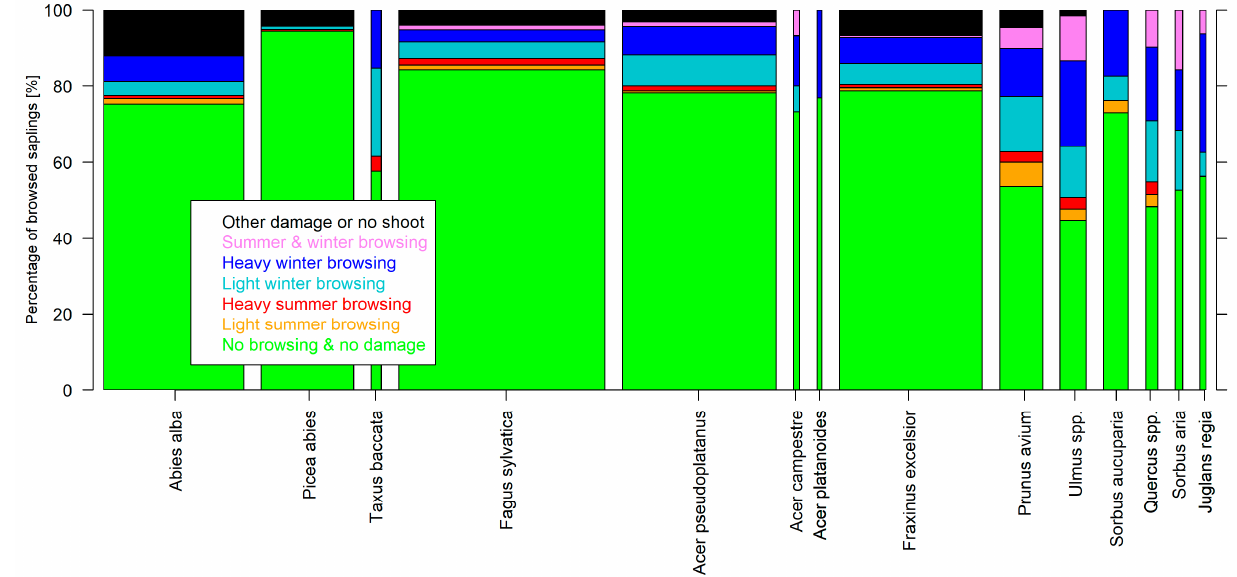
Figure 3. Percentage of browsed saplings of HC1 to HC4 per season and within-tree browsing intensity (including the nearest and second nearest saplings per height class). Only species with ≥ 13 observed trees in these height classes are displayed. The species are sorted into evergreen and deciduous species and according to descending occurrence, apart from Acer campestre and Acer platanoides for better comparison with Acer pseudoplatanus